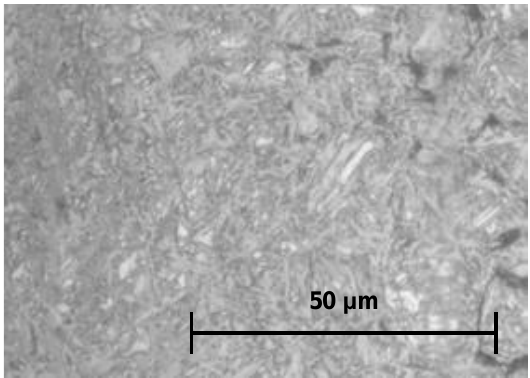
Figure 1. Microstructure of the used material (zoom: 500×). Table 1. Mechanical and physical properties of the material 16MnCr5 [35].